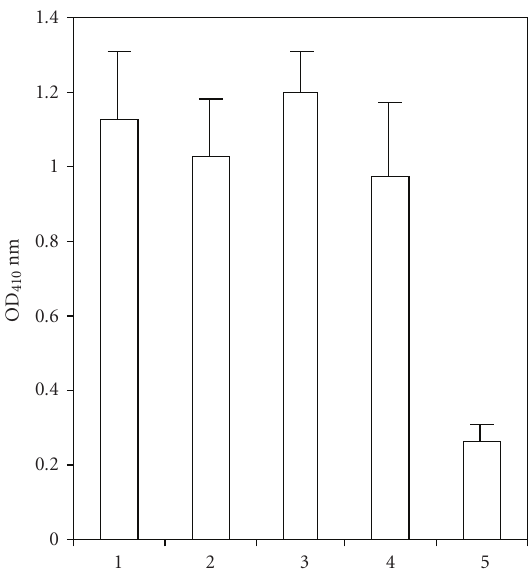
Figure 6: Testing 4 a ffi nity purified human IgG anti-dsDNA antibodies in binding to the synthetic peptide in ELISA. ELISA plates were coated with synthetic peptide (100 μ g/mL). Lanes 1–4 contain purified anti-dsDNA antibodies (1 μ g/100 μ L) binding to synthetic peptide and lane 5 has CF II as control binding to synthetic peptide. Antihuman IgG Fc fragment specific alkaline phosphatase conjugate was used to detect anti-dsDNA antibody binding. The data were expressed as the mean ± SD.